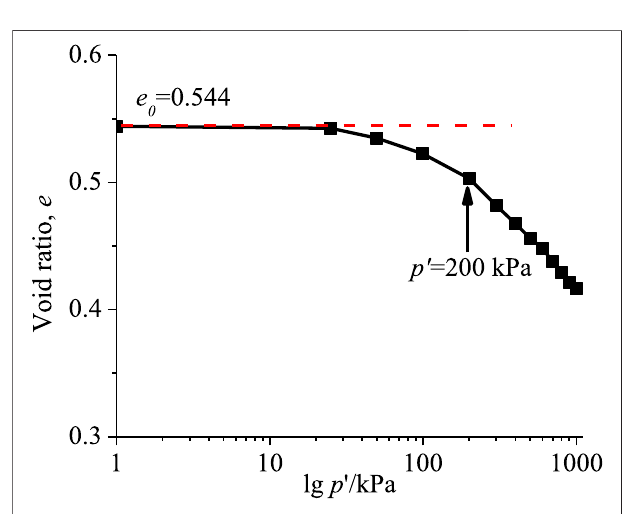
FIGURE 3 | e-lg p ’ relationships in oedometer